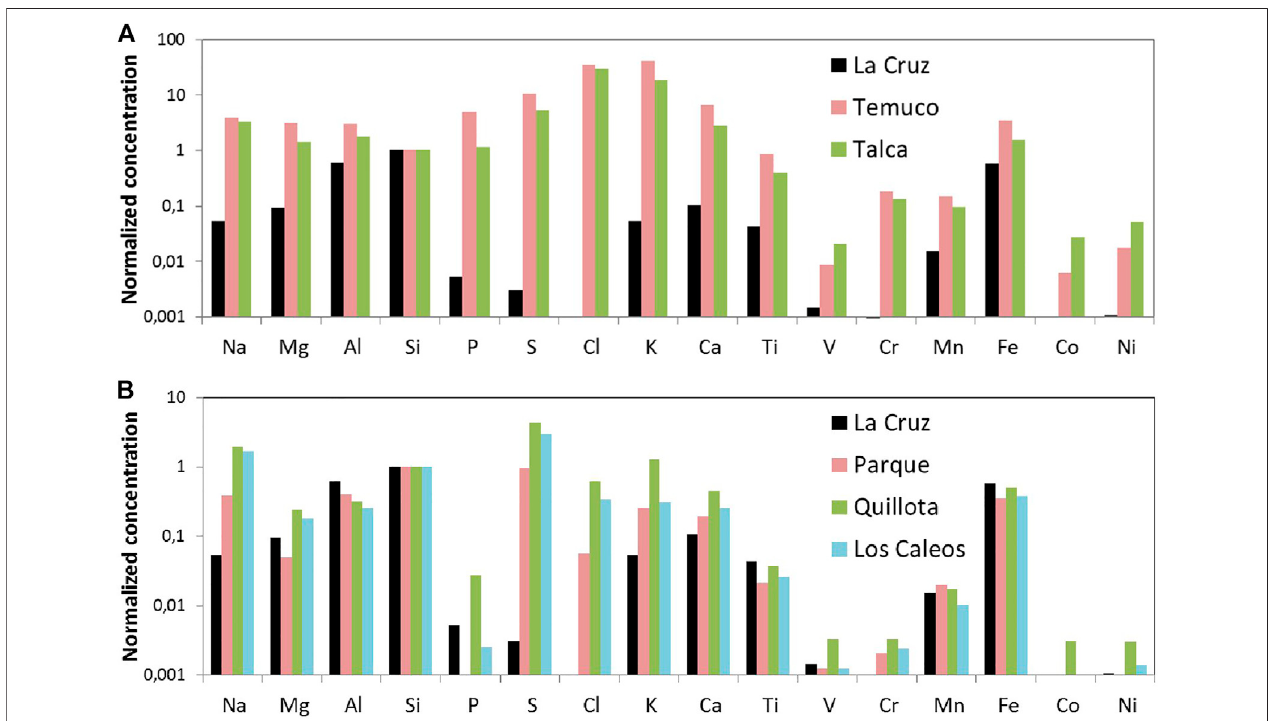
FIGURE 4 | Elemental composition by XRF of a dust sample in a clean site near Santiago (La Cruz) and the elemental composition of PM 2.5 from the fi ve sites. Concentrations have been normalized to Si. (A) La Cruz and southern sites: Temuco and Talca sites, (B) La Cruz and northern sites: Parque, Quillota and Los Caleos.